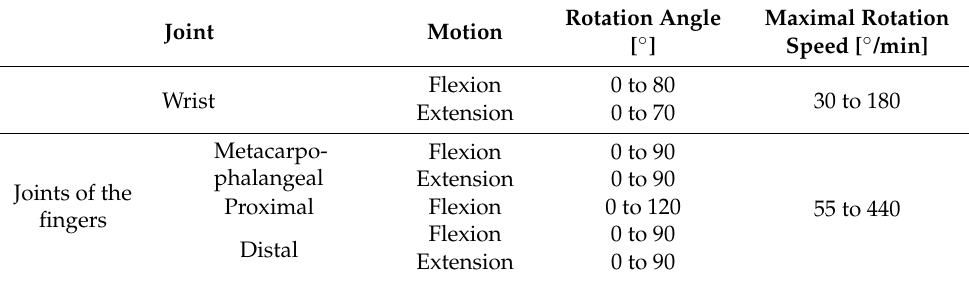
Table 1. Limits of the hand and finger joint motions.